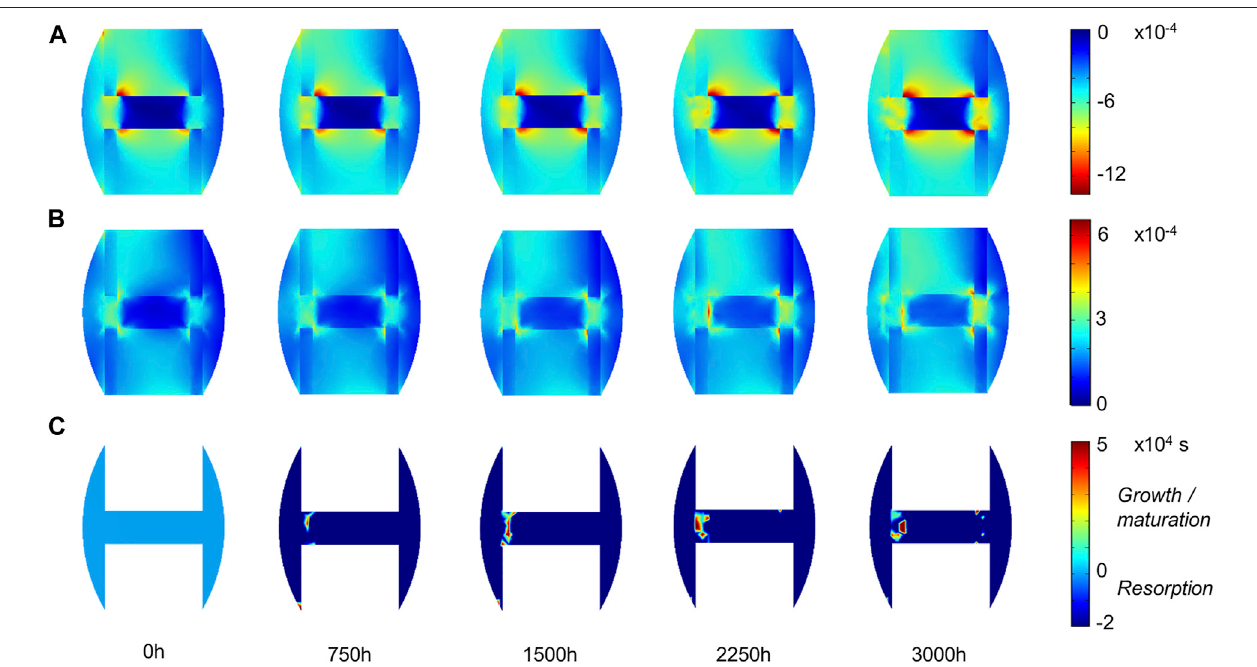
FIGURE 5 | Mouse fracture tissue mechano-sensation in mid-sagittal plane: (A) minimal principal strain ε III ; (B) maximal principal strain ε I ; (C) bone-speci fi c strain response function (restricted to its activation range). Other tissue-speci fi c strain response functions are not plotted, as they were constantly and uniformly equal to their minimal value (thus leading to